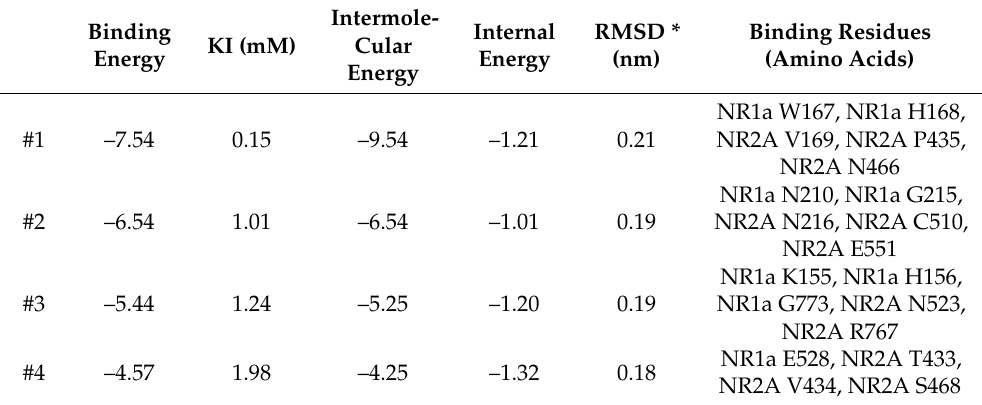
Table 2. The predicted docking sites and binding energy of NR1a/NR2A receptor and